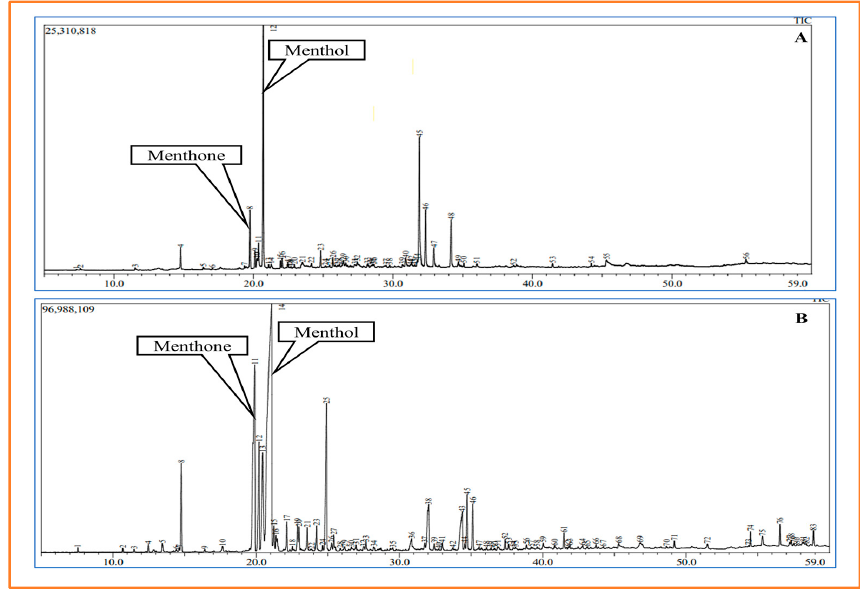
Figure 6. Chromatogram of EO content obtained from the leaves of peppermint (cultivar Kukrail). ( A ) Showing peak of menthol in control (peak 12), ( B ) Showing peak of menthol at 1.5% N (peak